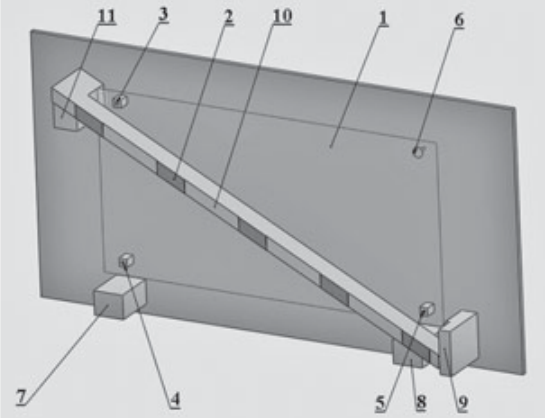
Figure 1 The scheme of the measurement station (explana- tion in the text) Slika 1 . Shema mjerenja (opis u